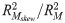
Significant rotational structure in PMd/M1 data and RNN model.Comparison of rotational dynamics for (a) observed, (b) permuted without covariance matching, and (c) covariance-matched data in the first jPCA plane. p-values in a are from the CMPT for the rotational goodness-of-fit ratio (RGR: RMskew2/RM2) in all jPCA planes. Conditions and neurons were randomly down-sampled in the PMd/M1 data to match the RNN model. Data is plotted for 200 ms regardless of time period used to generate statistics. Colors are based on the preparatory activity in the first jPC.